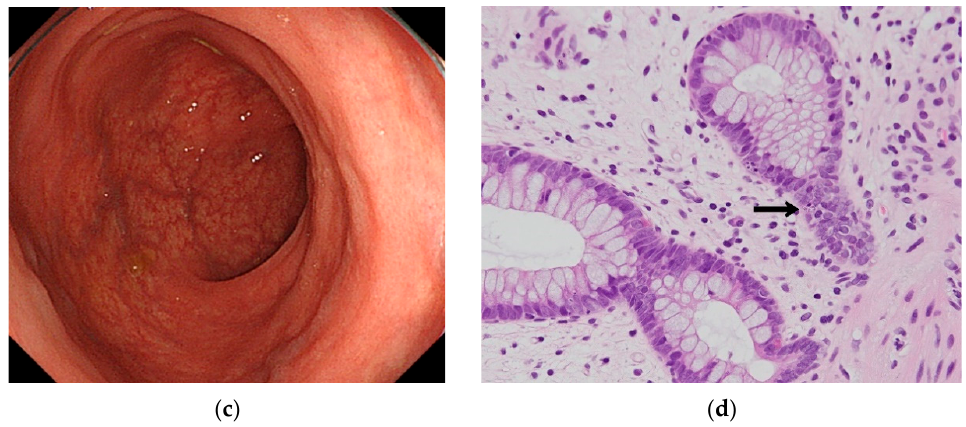
Figure 3. Colonoscopic findings after remission. No inflammatory finding was observed in the entire colon, but scarring is observed in areas with high inflammation, such as the cecum and sigmoid colon. The histopathological image depicts a few inflammatory cells without neutrophils. The apoptosis was decreased (arrow). The apoptoses were 1 per 10 crypts: ( a ) cecum; ( b ) sigmoid colon; ( c ) rectum; ( d ) pathological image of sigmoid colon.